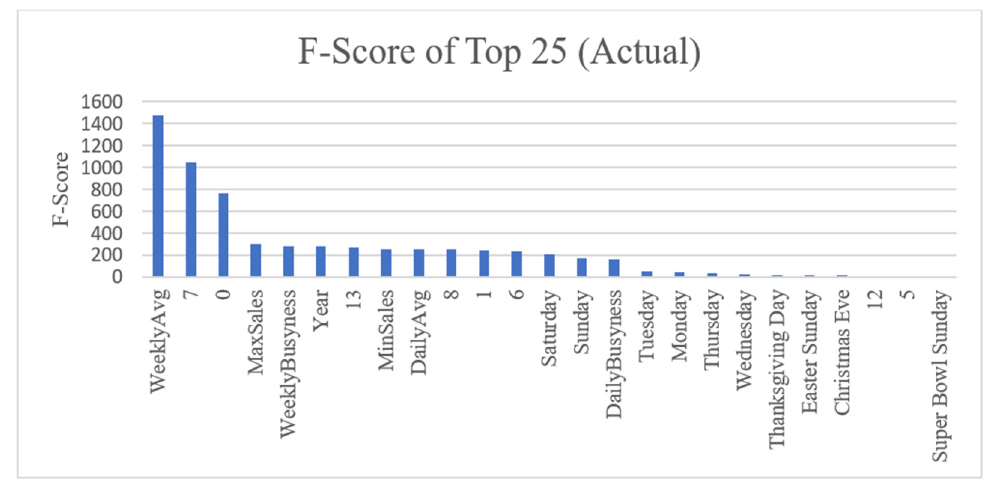
Figure 12. F-score for Top Features (Actual). The top 25 features as ranked by their F-scores. Weekly sales average is the highest scoring feature by far with other statistical metrics and days of the week following. Numbers 0–13 mark how many days until removal from the prediction window, so temporarily 13 is yesterday, 7 is one week ago, and 0 is two weeks ago.